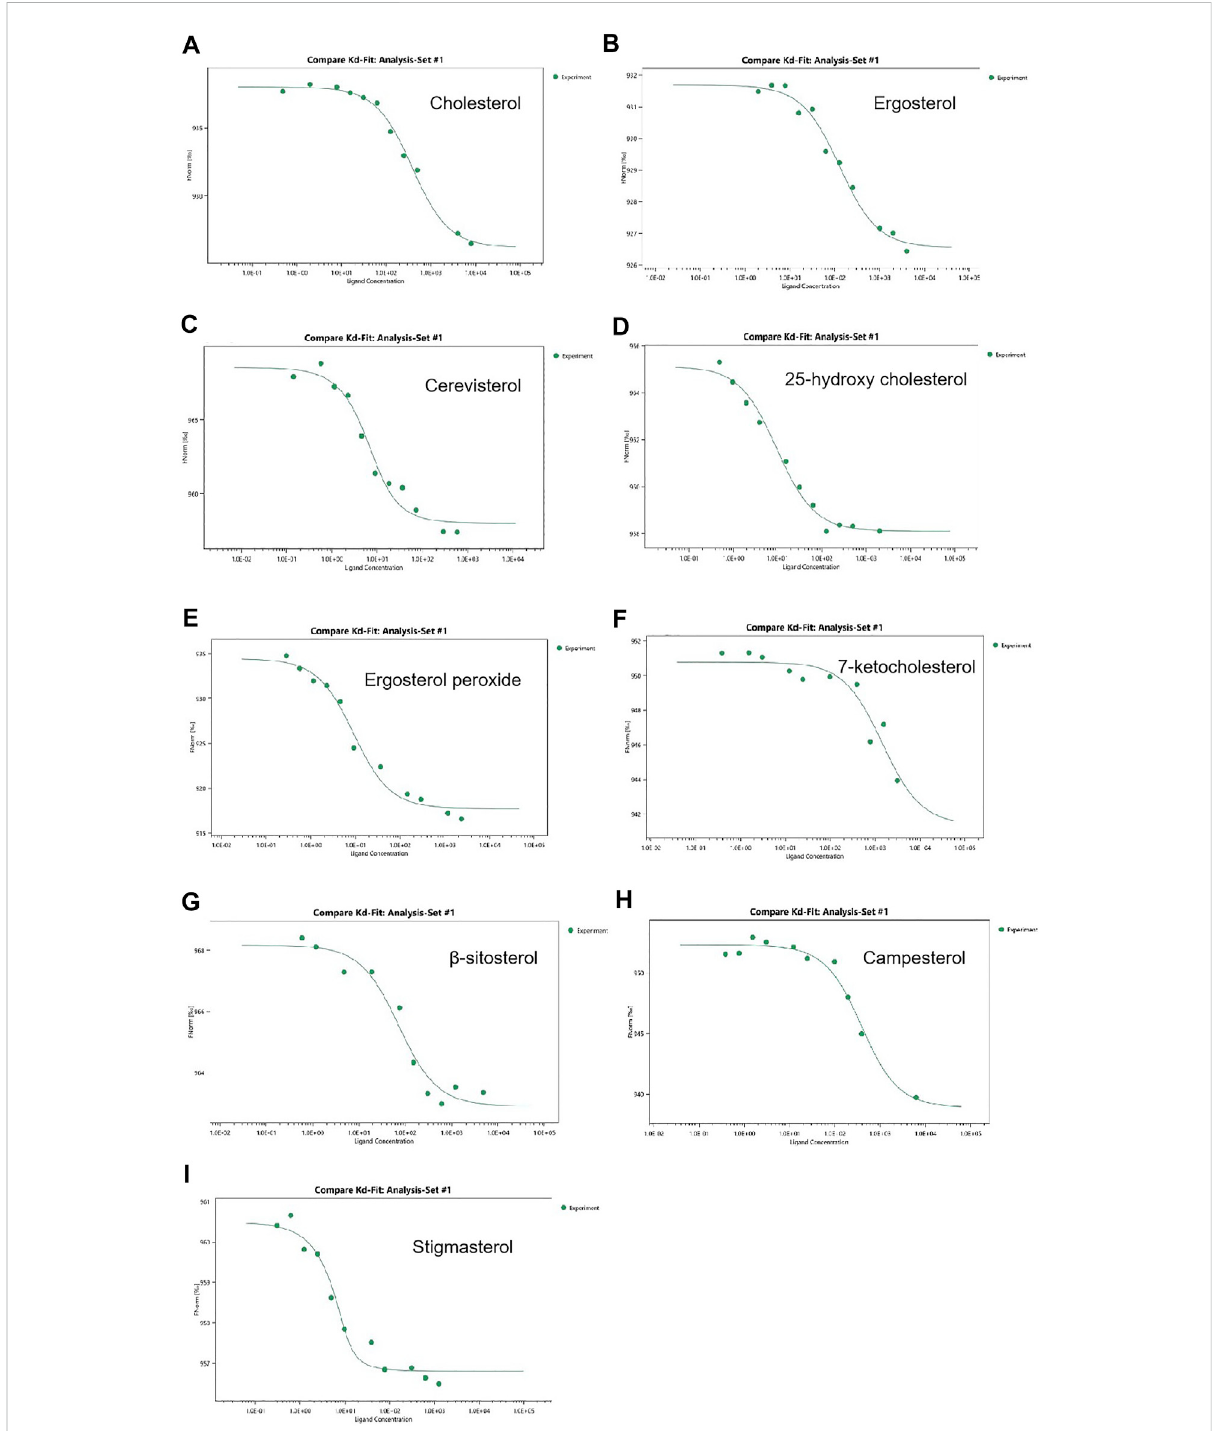
FIGURE 7 Determination of binding activity for ligand to Osh3 using the MST method. The binding af fi nity was analyzed using the NanoTemper monolith NT.115 instrument. (A) Kd of Osh3 for cholesterol was 332.9 ± 45.3 nM. (B) Kd of Osh3 for ergosterol was 121.9 ± 24.3 nM. (C) Kd of Osh3 for cerevisterolwas3.4±1.3 nM. (D) KdofOsh3for25-hydroxycholesterolwas9.1±2.0 nM. (E) KdofOsh3forergosterolperoxidewas8.1±2.1 nM. (F) Kdof Osh3 for 7-ketocholesterolwas 1,455.6 ± 1,088.3 nM. (G) Kdof Osh3 for β -sitosterol was65.8 ± 24.6 nM. (H) Kd ofOsh3 for campesterol was 339.5 ± 78.1 nM. (I) Kd of Osh3 for stigmasterol was 1.0 ± 0.8